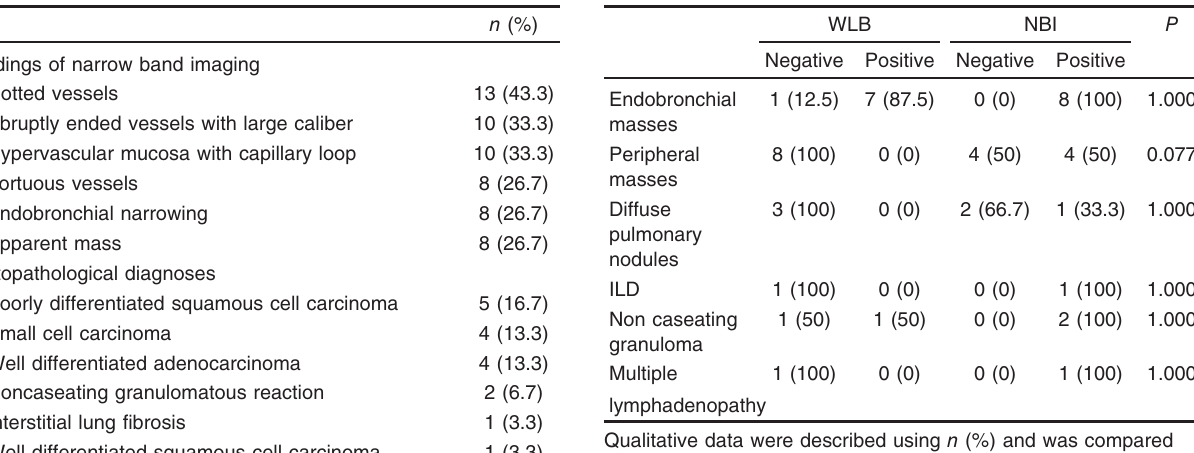
Table 4 Findings of narrow band imaging and histopathological diagnoses of group A Findings of narrow band imaging Dotted vessels